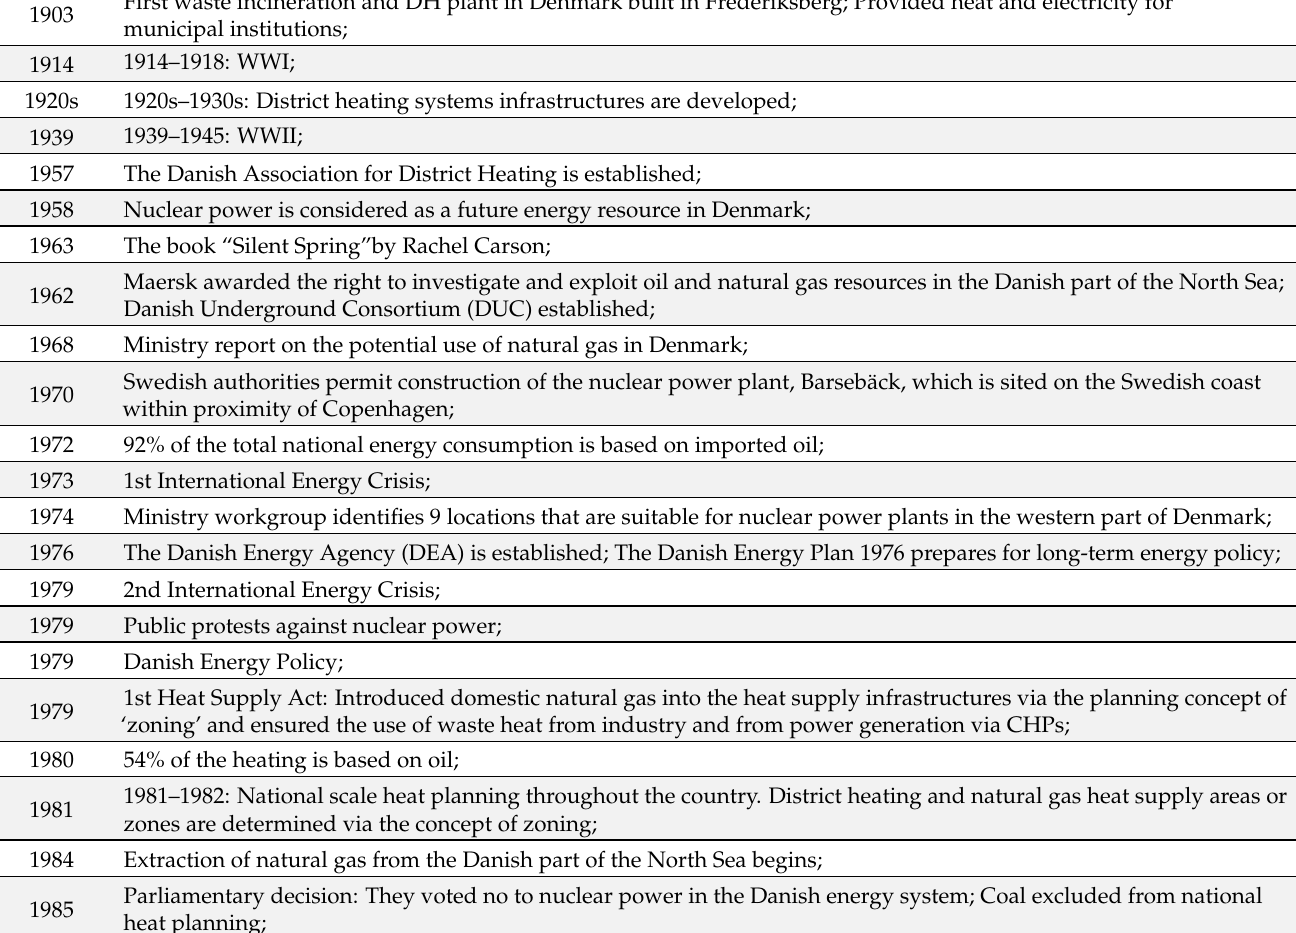
Table 1. Timeline: the first century of district heating in Denmark . This timeline shows key events that proved important for the Danish history of district heating. It notes key heat supply policy decisions, and important international reports and